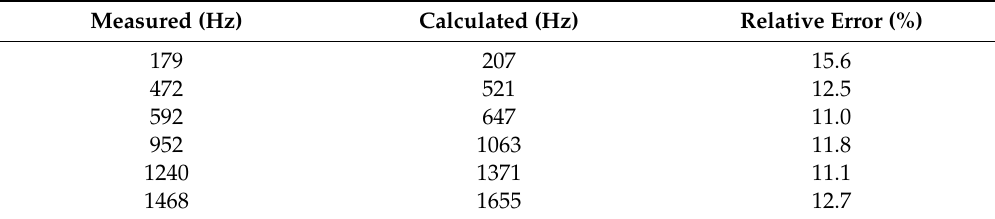
Figure 11. Finite element mesh of the cross-sectional region in the 3D model: ( a ) for electromagnetic field calculation; ( b ) for vibration calculation considering aluminum case.